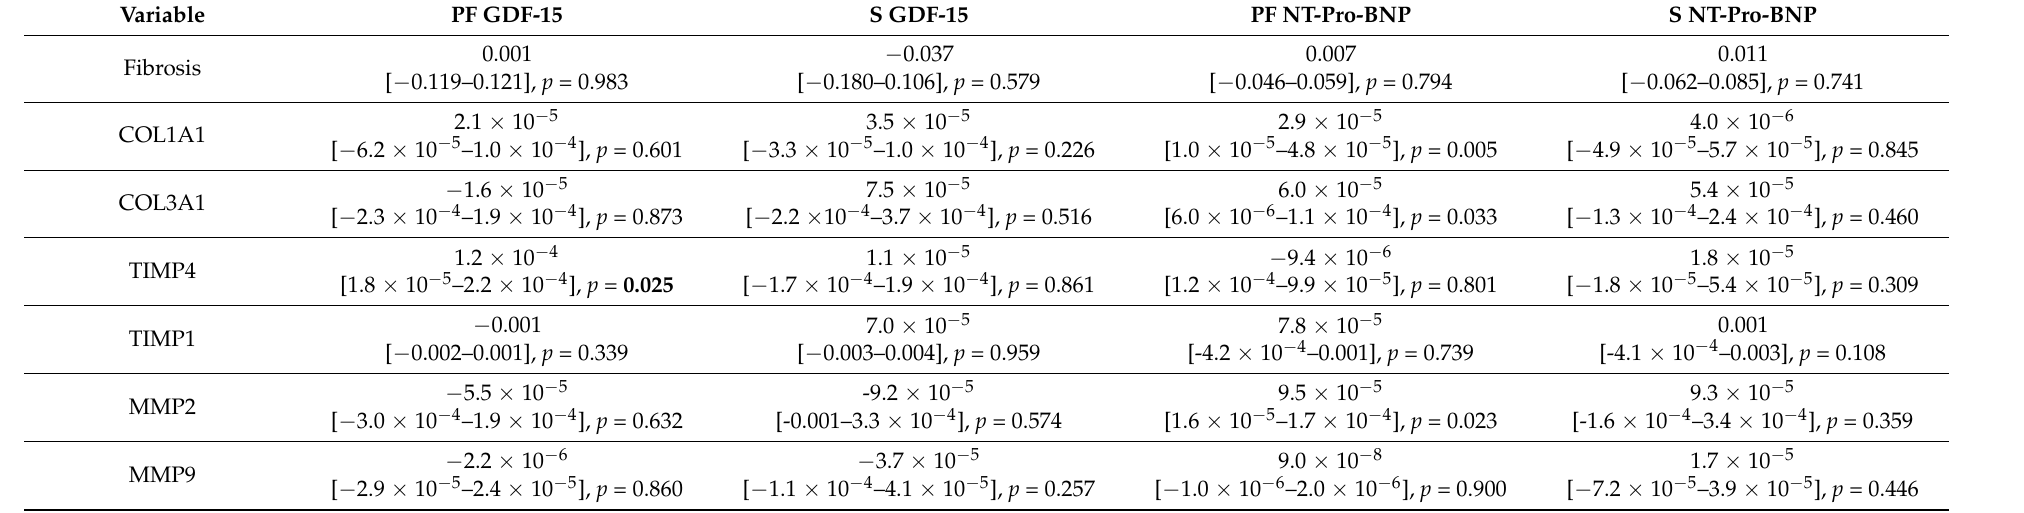
Table 2. Correlations between biomarkers and atrial matrix